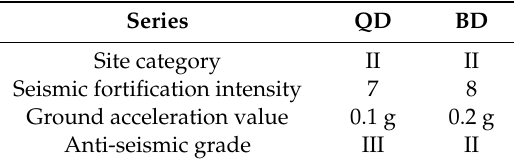
Table 1. Classification of specimens.